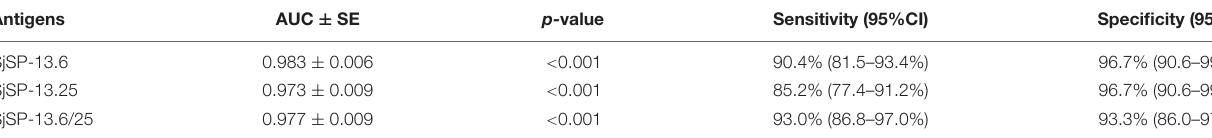
TABLE 1 | The diagnostic validity of SjSP-13.6, SjSP-13.25 and the combination of SjSP-13.6 with SjSP-13.25.